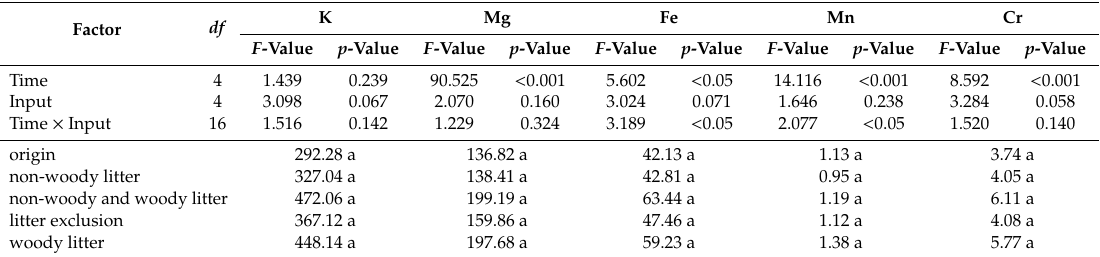
Table 4. Effects of time, debris input and their interaction on metals export of water tested by repeated‐measure ANOVA analyses.